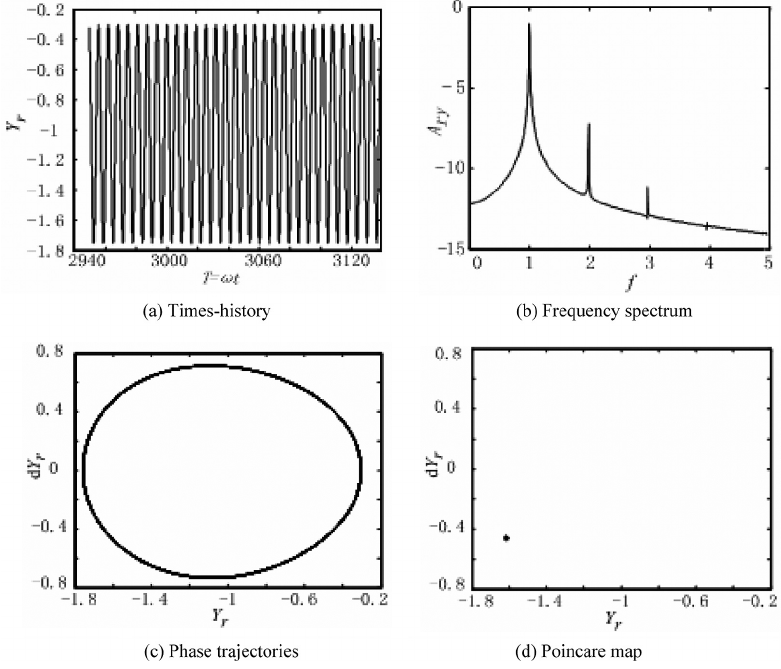
Fig. 5. Characteristics of the system when ω =240rad/s (without the pad moment of